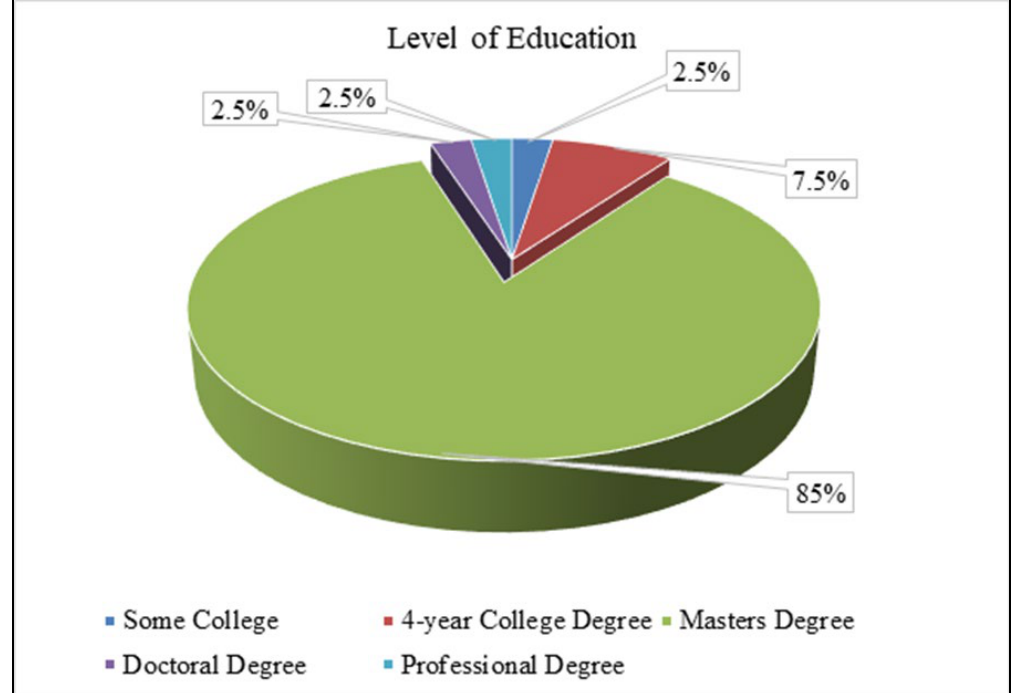
Figure 2 Frequency Distribution of Level of Education